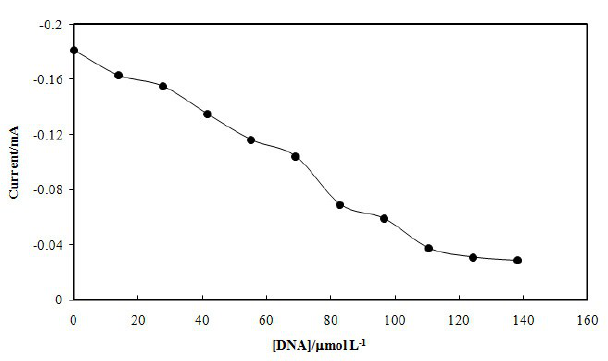
Figure 11. Dependence of cathodic peak current for EPR at different concentrations of ＝ 0.0, 13.8, 27.6, 41.5, 55.3, 69.1, 82.9, 96.7, 110.6, 124.4 and DNA. Conditions: C DNA ＝ 10.0 μmol L -1 , Scan rate = 100 mV s -1 , phosphate buffer (0.1 mol L -1 , 138.2 μmol L -1 , C EPR pH 7.4) and potassium chloride (0.1 mol L -1